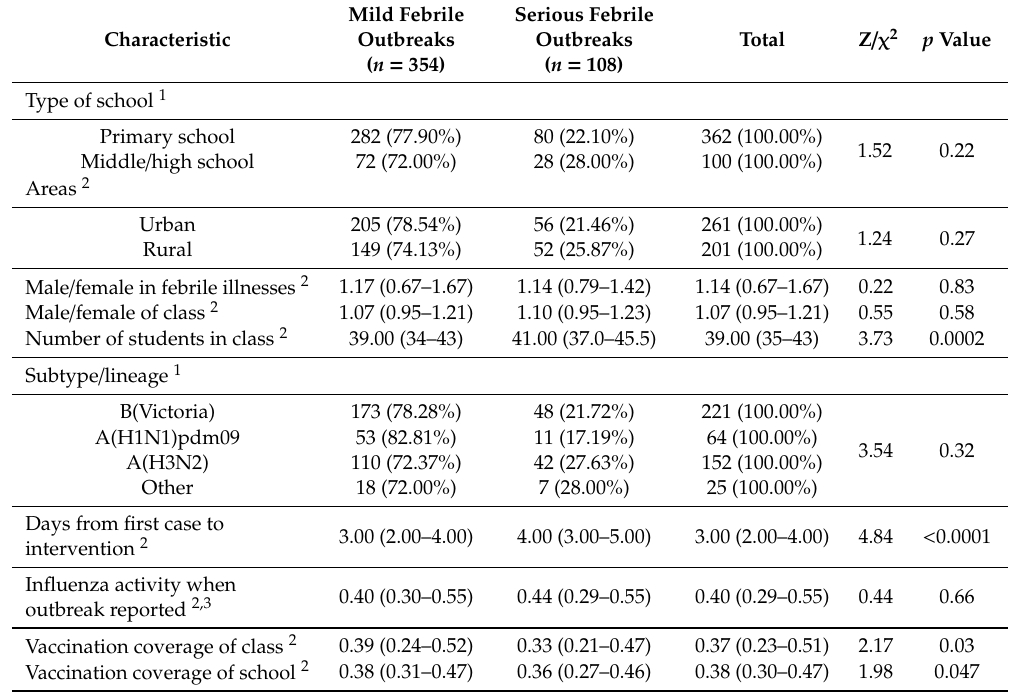
Table 1. Characteristic of febrile outbreaks in school in Beijing, from August 2018 to July 2019.